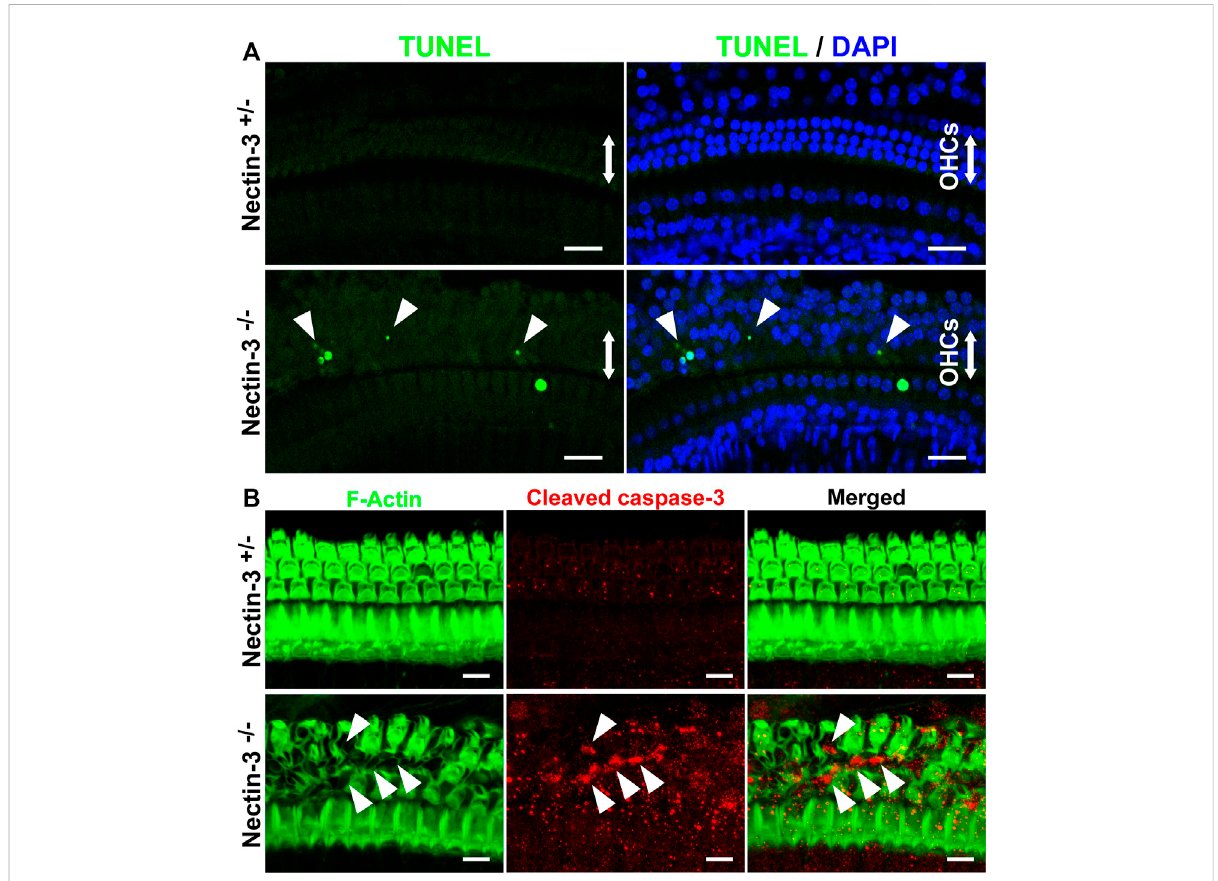
FIGURE 5 Apoptotic cell death of hair cells in nectin-3 KO mice (A) TUNEL assays inthe middle turn ofnectin-3 +/ – and nectin-3 − / − cochleaon P28. Nuclei were counterstained with DAPI (blue). Note the TUNEL-positive (green) condensed nuclei in nectin-3 − / − cochlea. Arrowheads indicate TUNEL- positive outerhaircells. Scalebarsare20 μ m. (B) Immuno fl uorescence images oftheorgan ofCortiinthemiddle turninnectin-3 +/ – andnectin-3 − / − mice on P24 using an anti-cleaved caspase-3 antibody (red) and phalloidin (green). Cleaved caspase-3 signal, which indicates the induction of apoptosis, was not detected in the auditory epithelium in nectin-3 +/ – mice. The cleaved caspase-3 signal was detected only in the outer hair cell region in nectin-3 − / − mice. The difference in the number of TUNEL-positive and caspase-positive cells might re fl ect the difference in the time required to induce cell death and the time it takes for the dead cells to be removed. Arrowheads indicate the positive cells. Scale bars are 20 μ